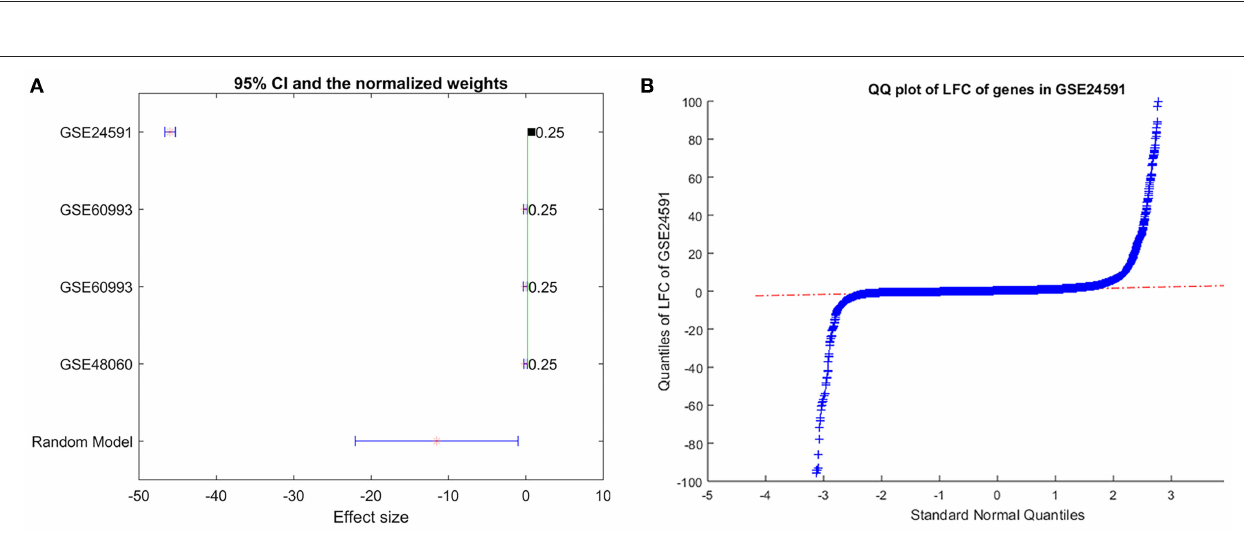
FIGURE 4 | Expression of gene PTH analysis results. (A) Forest plot of the mega-analysis results of PTH; (B) QQplot of the dataset GSE24591, which includes gene PTH.